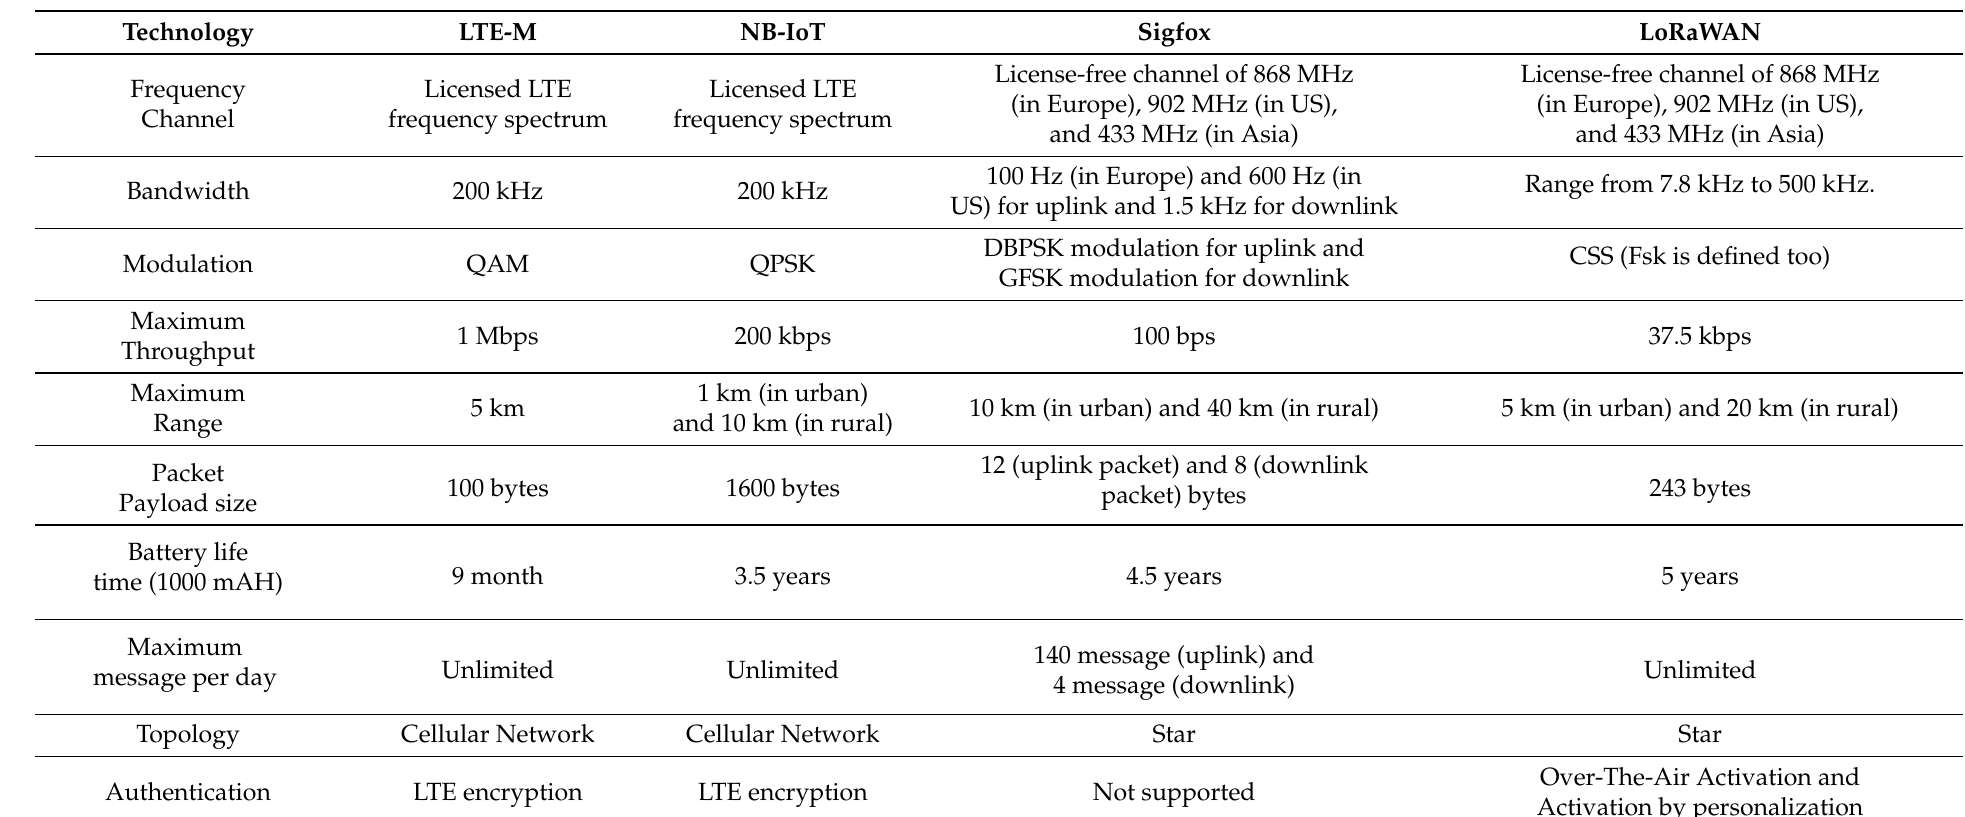
Table 1. Comparison of main technical features of LPWAN